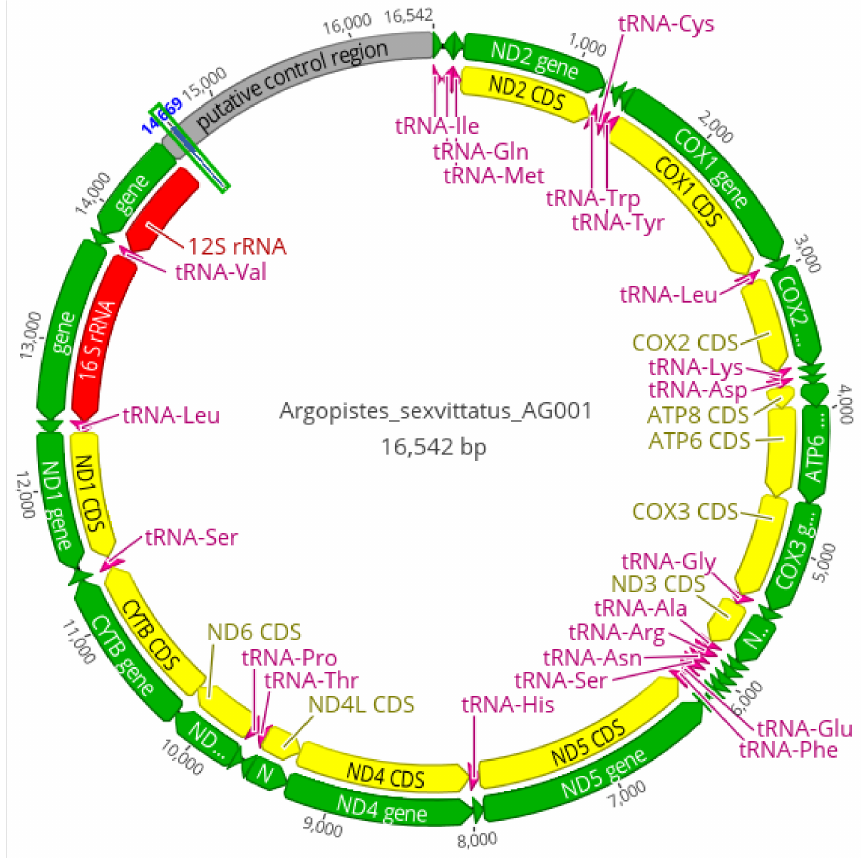
Figure 4. Circular map of the complete mitochondrial genome of Argopistes sexvittatus and A. capensis, here represented by A. sexvittatus AG001. Arrows indicate the direction of gene